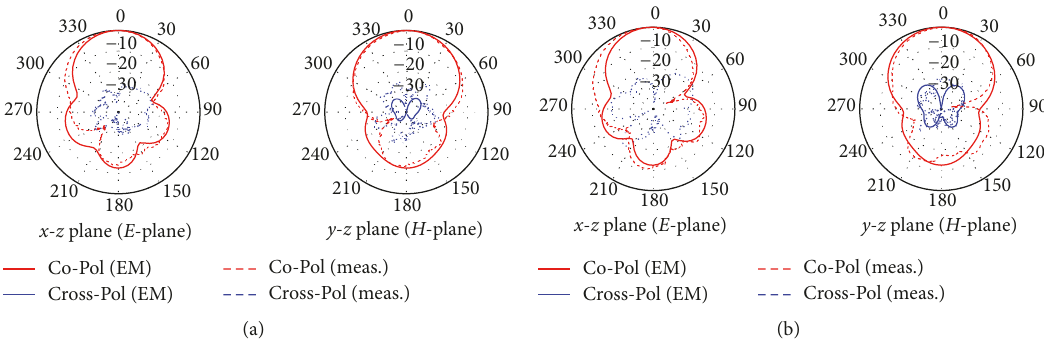
Figure 9: Measured and simulated normalized radiation patterns at 2.3 GHz at (a) E -plane and H -plane for Port 1 and (b) E -plane and H -plane for Port